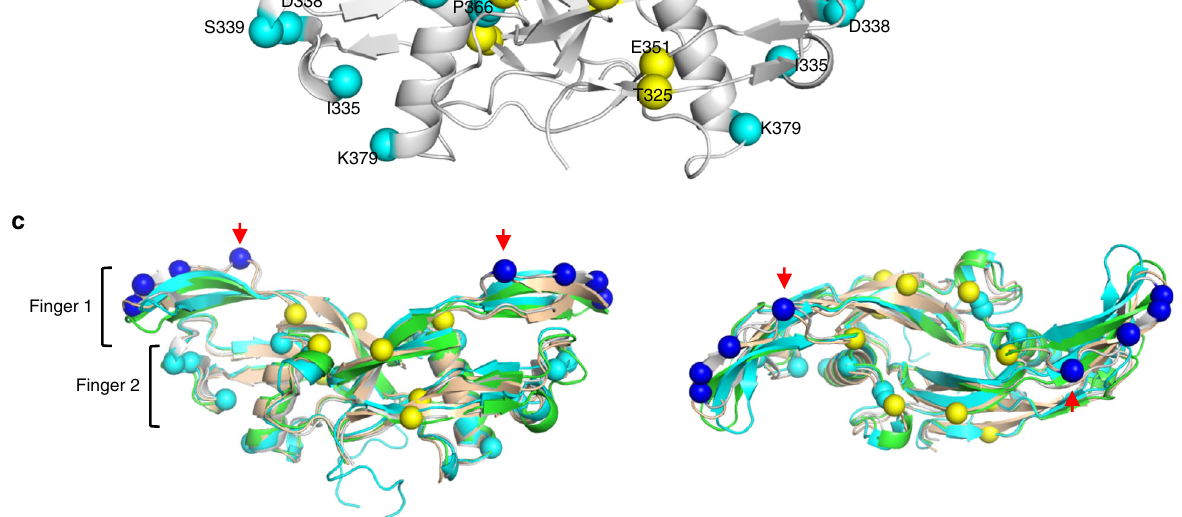
Reciprocally, ALK1 evolved a negatively charged residue with a longer side-chain at the corresponding position, E75, to allow the H-bond formation with Y413, de fi ning its speci fi city for BMP9 and BMP10. The site I region contains residues that are different between BMP9 and BMP10, with the interactions predominantly mediated by sidechains (Fig. 4e). In contrast, the core of the